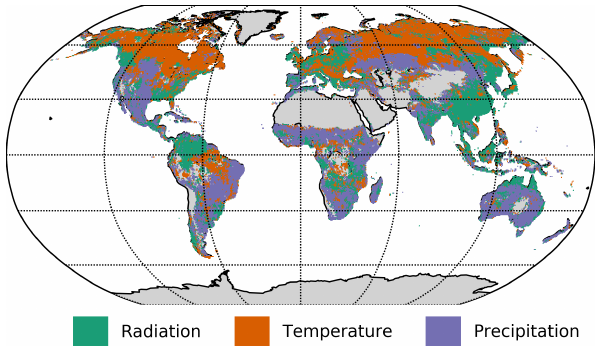
Figure 7. Map of the strongest climatic driver (largest absolute MCI value) per grid